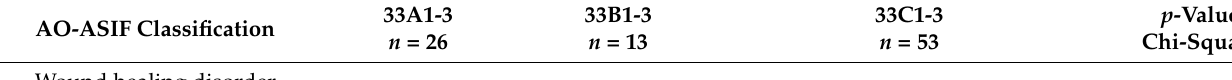
Table 3. Sub-analysis of correlation between fracture entity and postoperative complications.